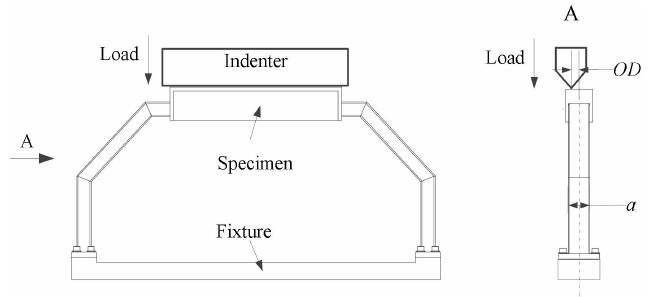
Figure 3. Loading